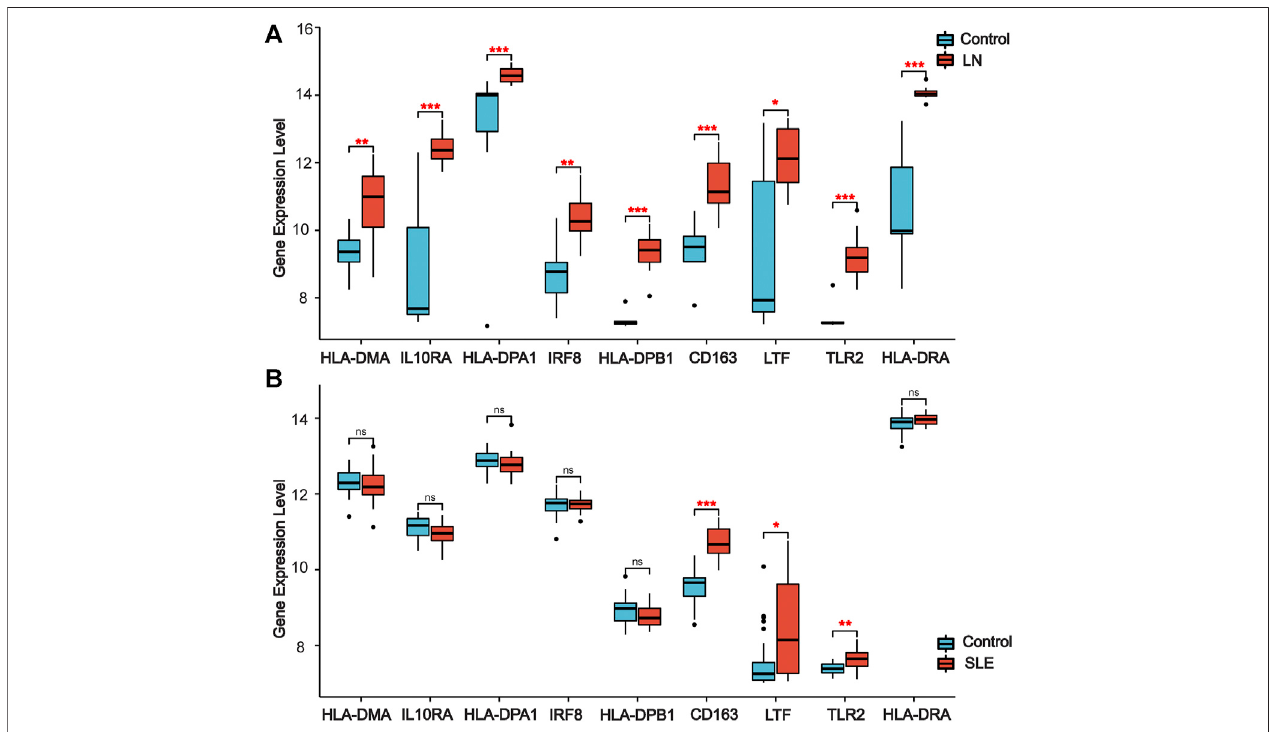
FIGURE 5 | | Validation of co-DEGs in additional LN and SLE datasets. (A) Expression ofco-DEGs in the additional LN dataset GSE112943. (B) Expression of co- DEGs in the GSE81622 SLE dataset. (* p < 0.05, ** p < 0.01, *** p <